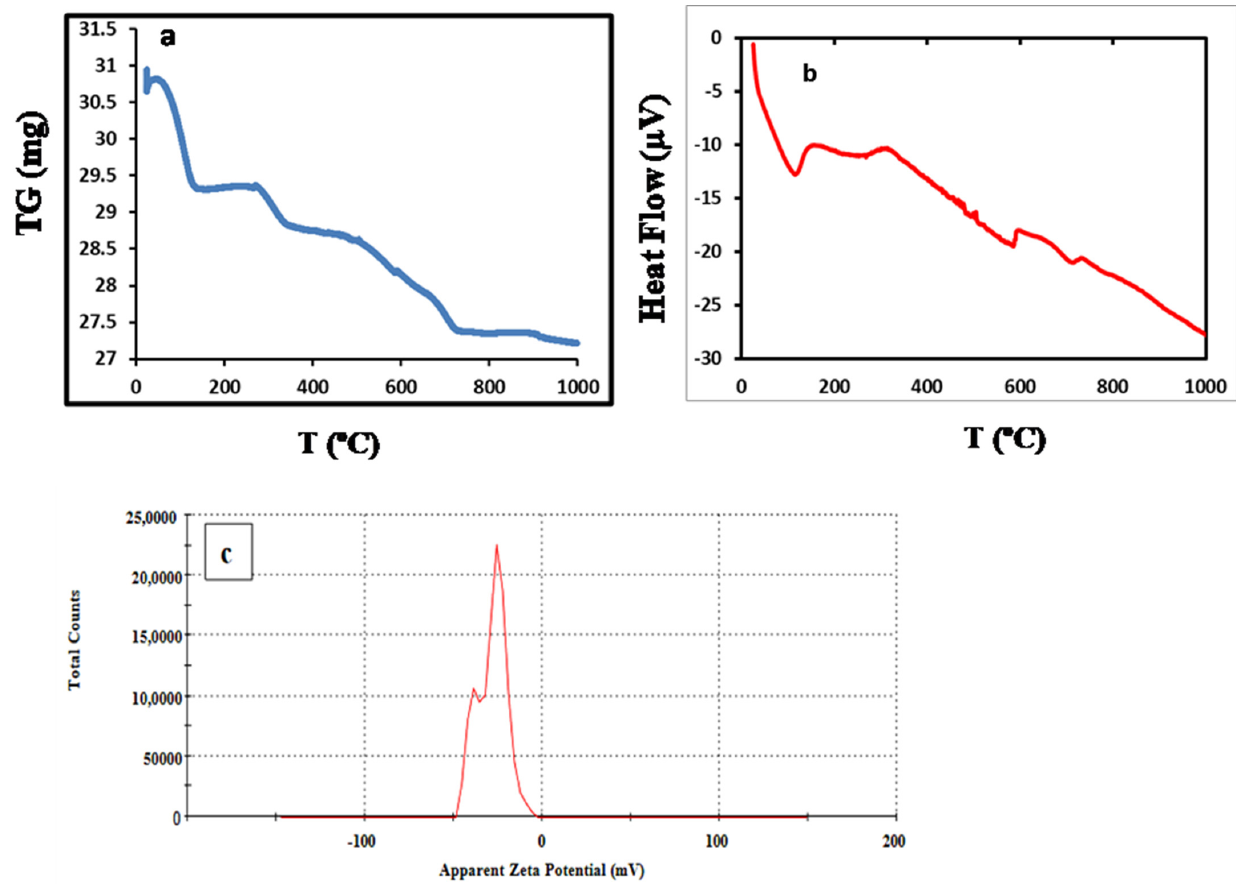
Figure 4. TGA ( a ), DSC ( b ), and zeta potential ( c ) results of